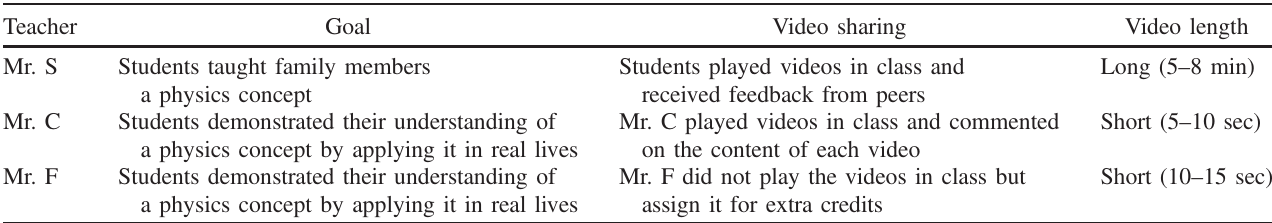
TABLE IV. The three teachers ’ different ways of implementing the strategy of